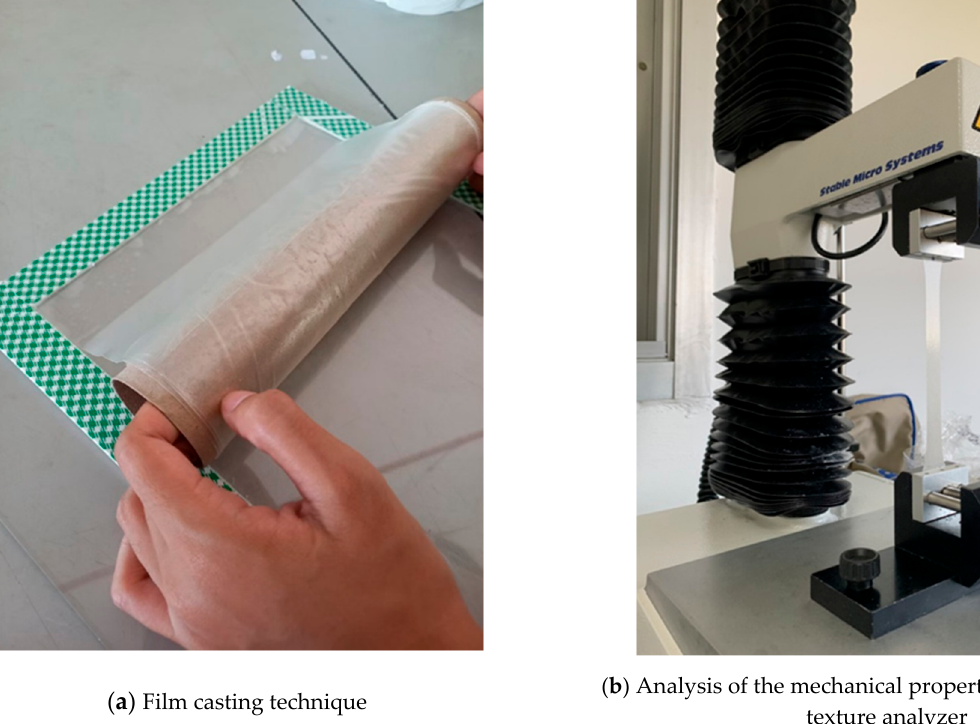
Figure 2. Casting the PVA/ST/WMRE film ( a ) and analysis of the mechanical property of the film on the texture analyzer ( b ). Table 2. Mechanical properties of PVA/ST and PVA/ST/WMRE films. The different letters represent a significant difference of p < 0.05. The error bar indicates the standard deviation (n = 3).